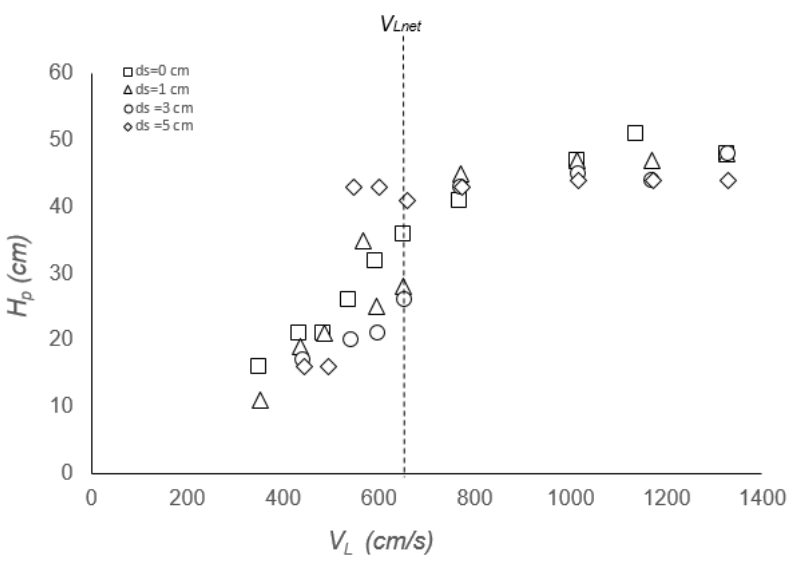
Figure 11. Total air entrainment rates for varying V L at different L j s for ( a ) ds = 0, L j = 43 cm and 46 cm; ( b ) d s = 1, L j = 44 cm and 37 cm; ( c ) d s = 3, L j = 46 cm and 40 cm; and ( d ) d s = 5, Lj = 48 cm and 43 cm.